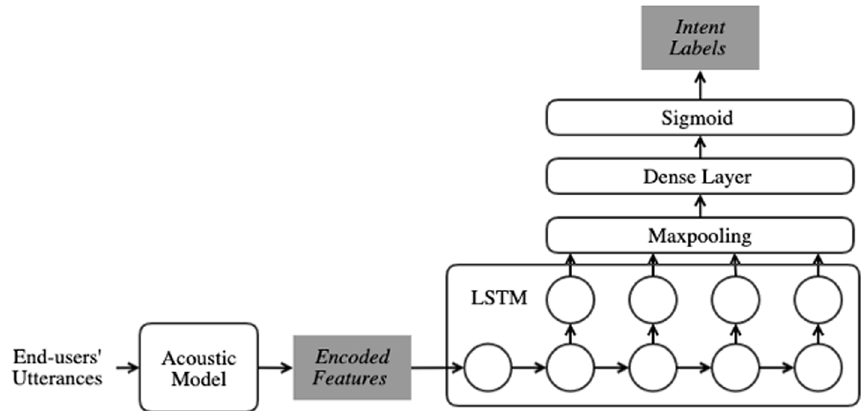
Fig. 8 The structure of the LSTM-based intent